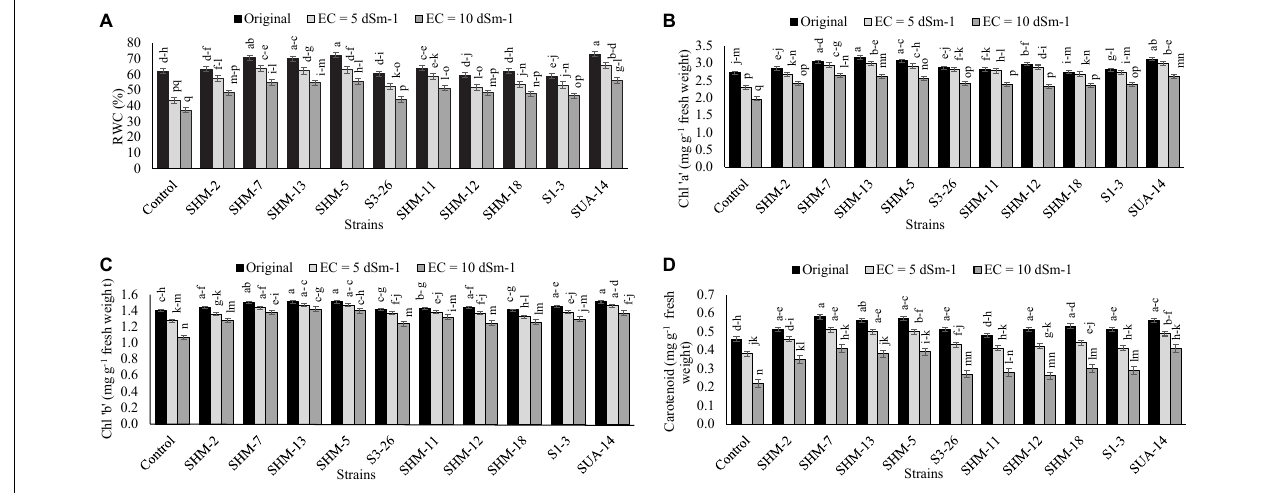
FIGURE 3 | Effect of rhizobacterial inoculation on the physiological attributes, i.e., (A) Relative water contents (%), (B) Chlorophyll “a”. Effect of rhizobacterial inoculation on relative water contents (RWCs) (%), (C) Chlorophyll “b” (mg g − 1 fresh weight), and (D) carotenoid (mg g − 1 fresh weight) contents of maize under salt-stressed pot conditions. Bars sharing the same letters are statistically non-significant at p ≤ 0.05.